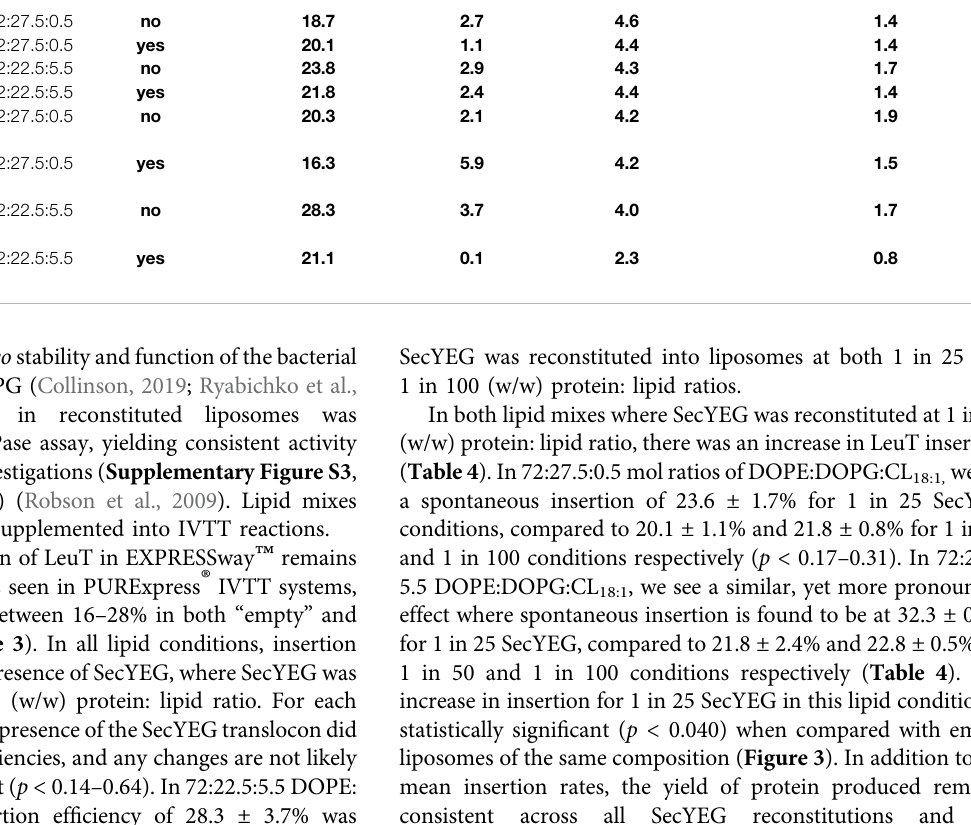
TABLE 3 | The individual lipid compositions used for conditions where SecYEG was either present or absent 1 – 4. SecYEG was reconstituted at a ratio of 1 in 50 (w/w) protein: lipidinconditionswherepresent.Averagetotalyields refertothetotalamountofprotein synthesizedduring IVTT,andaverageyieldpuri fi edreferstotheamount of protein recovered after sucrose gradient puri fi cation. We can consider the protein lost between synthesis and puri fi cation to be aggregated or non-inserted. The mean insertion ef fi ciencies (%) are presented for each condition with SecYEG absent or present. Errors presented are SEM calculated from a minimum of 3 repeats, any experimental results disregarded can be found in Supplementary Table S5 and S6 . All experiments were conducted in Expressway ™ . Lipid Composition